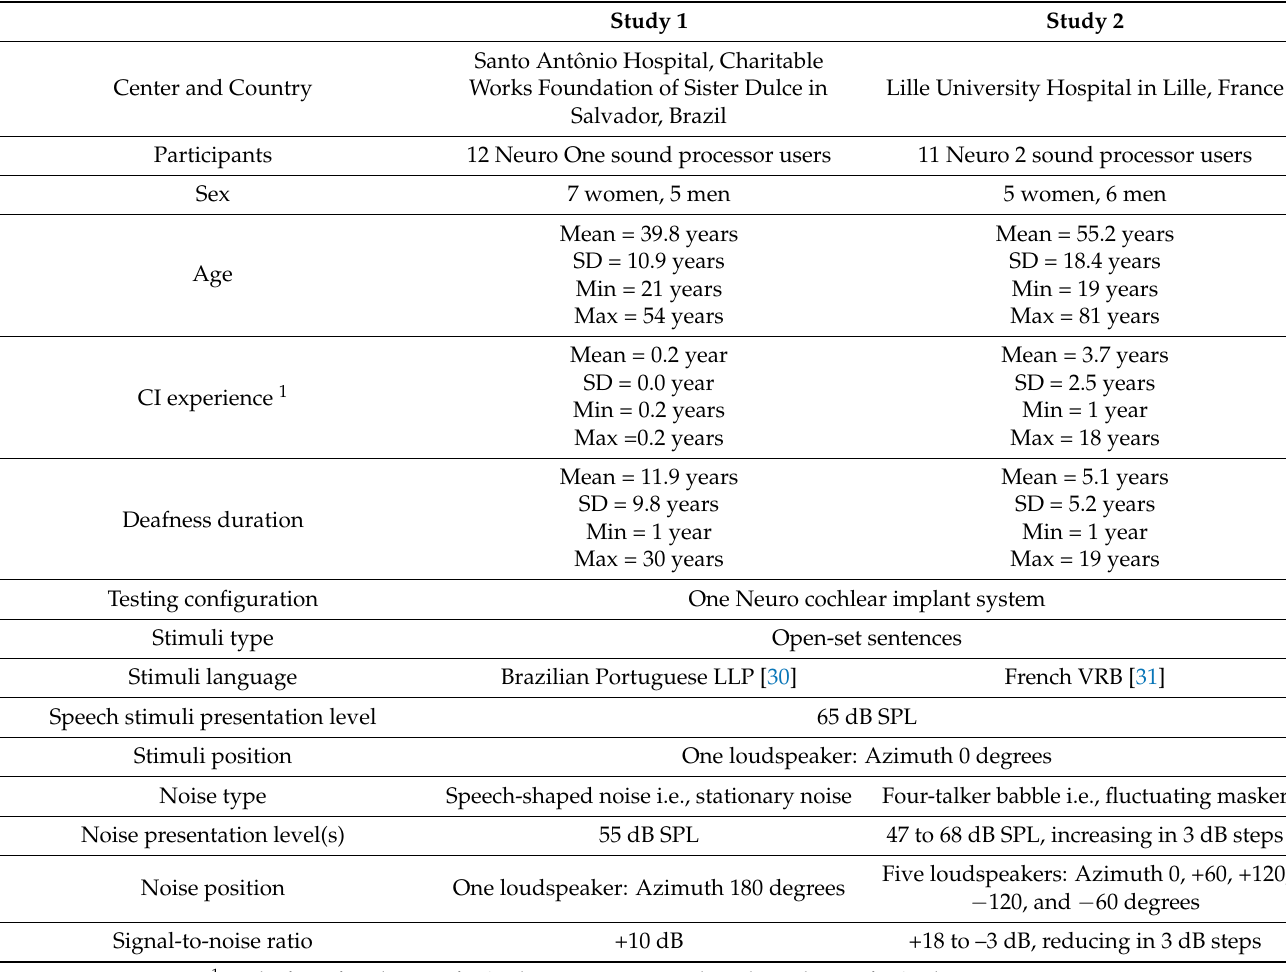
Table 1. Summary of the methods and participants for the two